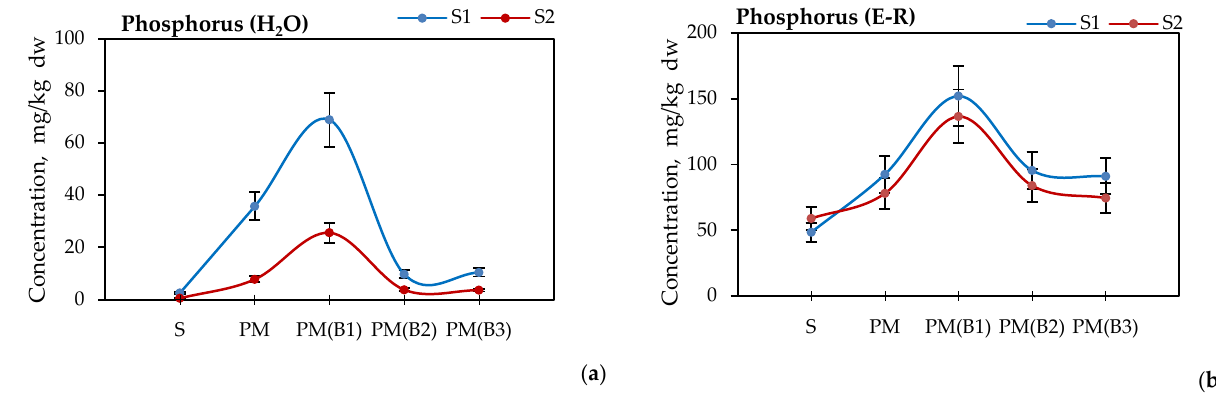
Figure 2. Concentration of phosphorus in soils and their blends treated with 2 wt.% poultry manure (PM) and biocidal agents B1—calcium peroxide, B2—sodium percarbonate, B3—calcium hydroxide, S—soils without treatment (S1 or S2); ( a ) extraction with water, ( b ) extraction with calcium lactate (Egner–Riehm method).